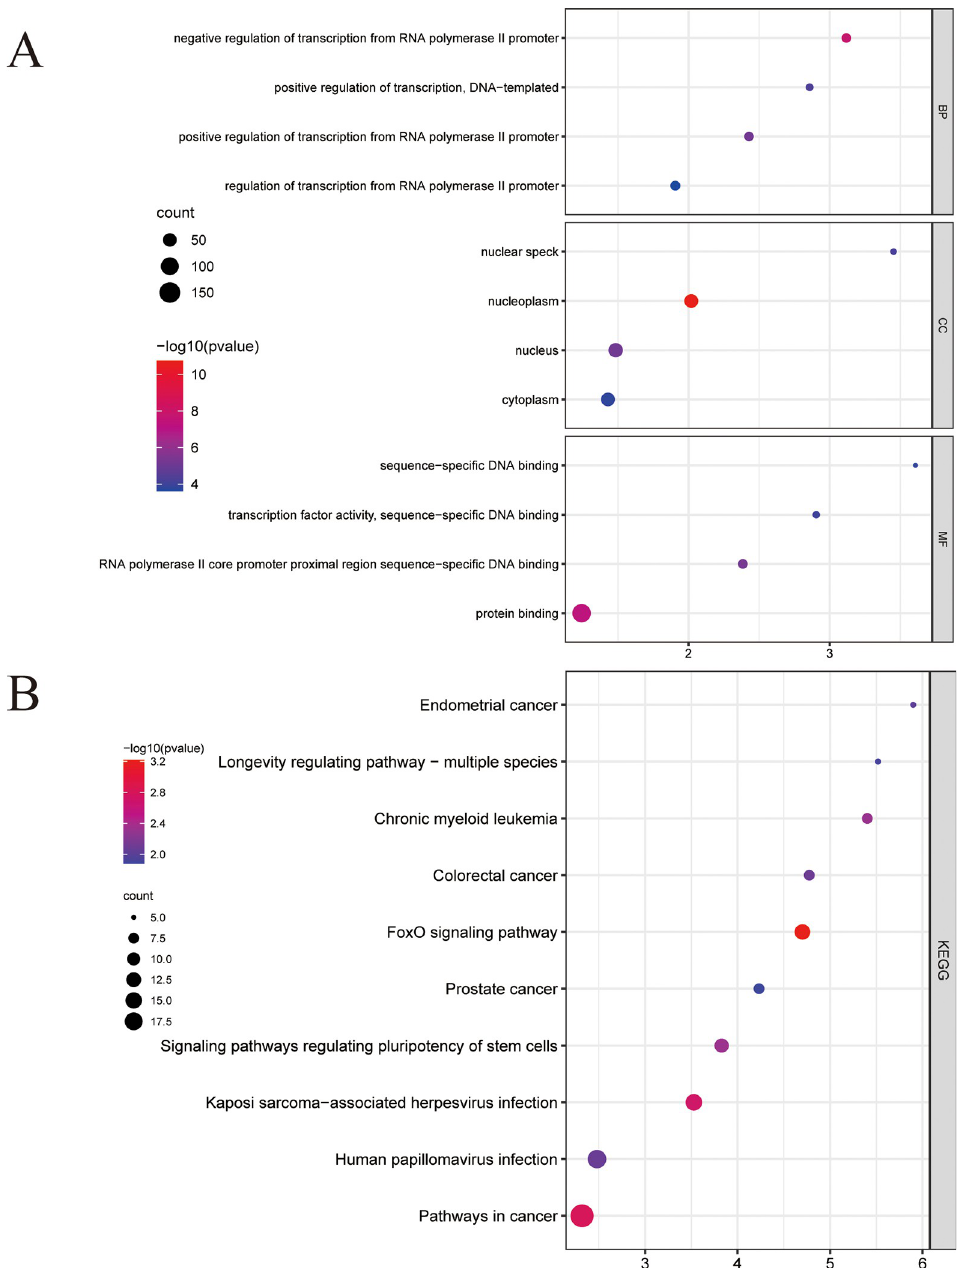
Fig 6. DAVID enrichment analysis. A: GO enrichment analysis: BP, biological process; CC, cellular component; MF, molecular function. The abscissa represents the number of enriched genes, while the ordinate describes the enriched items. The darker the bar color, the more significant the difference between the enriched items. B: KEGG enrichment analysis: the abscissa represents the number of enriched genes, while the ordinate represents the enriched pathway entries. Many cancer pathways and some common pathways are shown. The size of the circle represents the number of enriched genes: the larger the circle, the higher the number of enriched genes, and the redder the color, the closer the relationship with the enriched